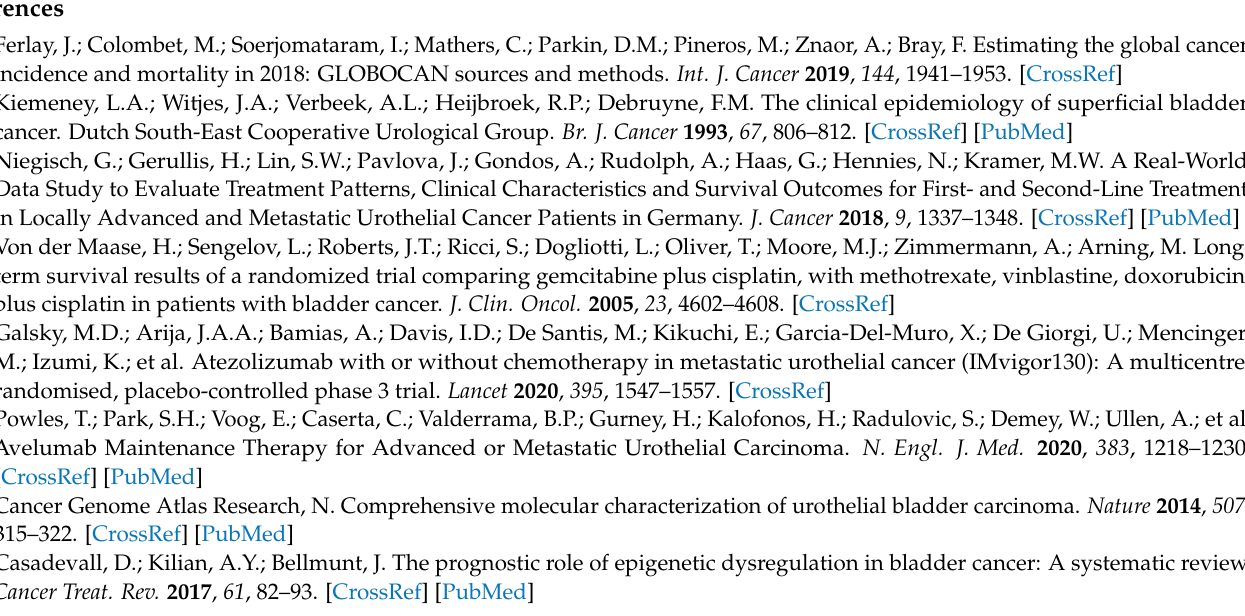
after HDACi treatment. Figure S5: Example flow cytometry raw data for phosphorylated H3 in VM-CUB1 cells treated with different HDACi. Figure S6: Example flow cytometry raw data for phosphorylated H3 in UM-UC-3 cells treated with different HDACi. Table S1: Antibodies used in this study. Table S2: Mutations in queried genes in UCC according to CCLE database. Table S3: Copy number alterations of queried genes in UCC according to CCLE database. Table S4: IC 50 doses for used pharmacological inhibitors and actual dosage for combination treatment with fixed dose